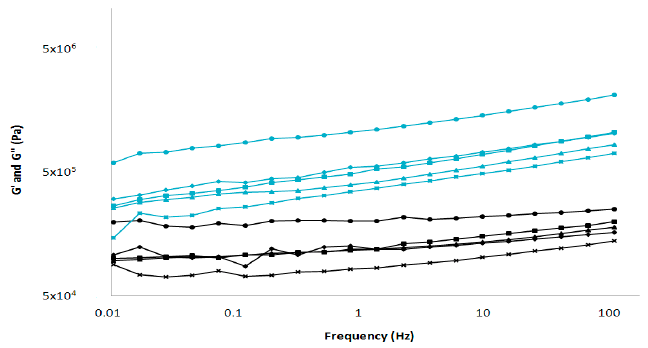
Figure 2. Average graph of storage modules (G’) and loss modules (G’’) for the five Poro cheese factories: ( (cid:7) ) QP1, ( (cid:78) ) QP2, ( (cid:8) ) QP3, ( × ) QP4 and ( (cid:4) ) QP5.